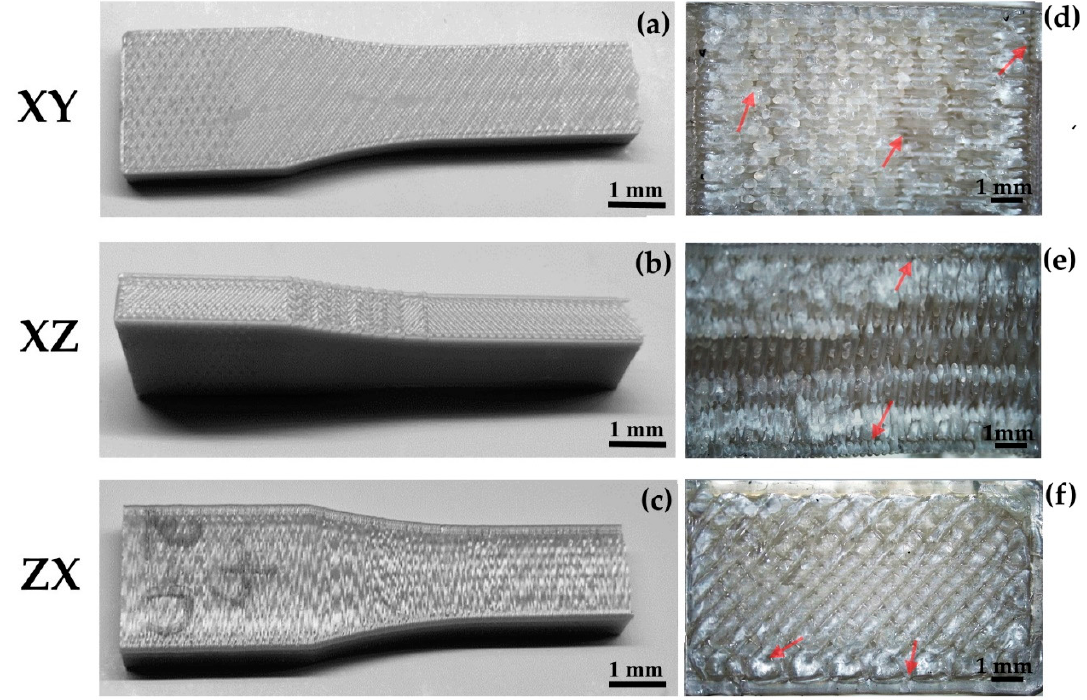
Figure 2. Samples built in XY, XZ, and ZX building directions after tensile tests. Macroscopic views of samples ( a – c ) and fracture surfaces ( d – f ).